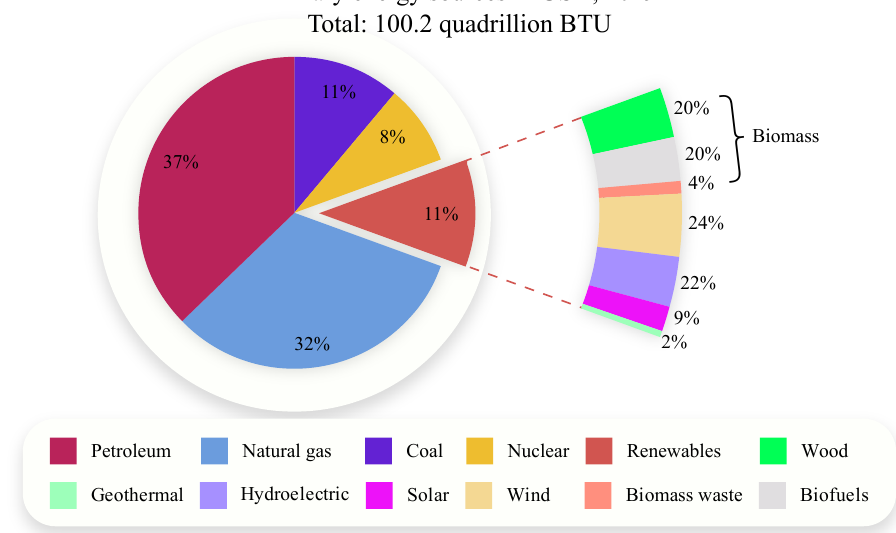
Figure 17. The U.S. energy mix is dominated by fossil fuels as of 2019, with renewable energy sources comprising a mere 11%. Solar energy has still a long way to go to emerge as a trusted energy source